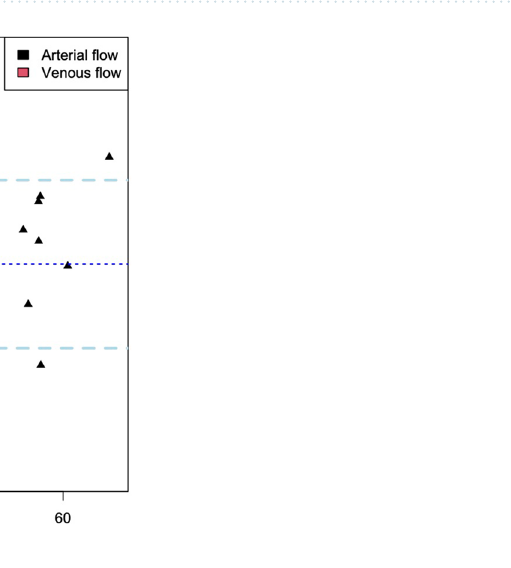
Figure 3. Average net flow through the PV for volunteers (left) and patients (right). Error bars indicate the standard deviation. Plot created using R.